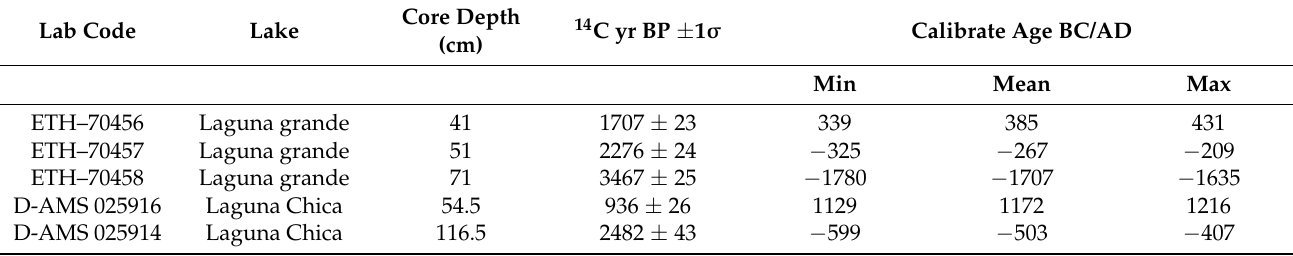
Table 2. Radiocarbon date of bulk sediments from the Laguna Grande and Laguna Chica de San Pedro. Lab